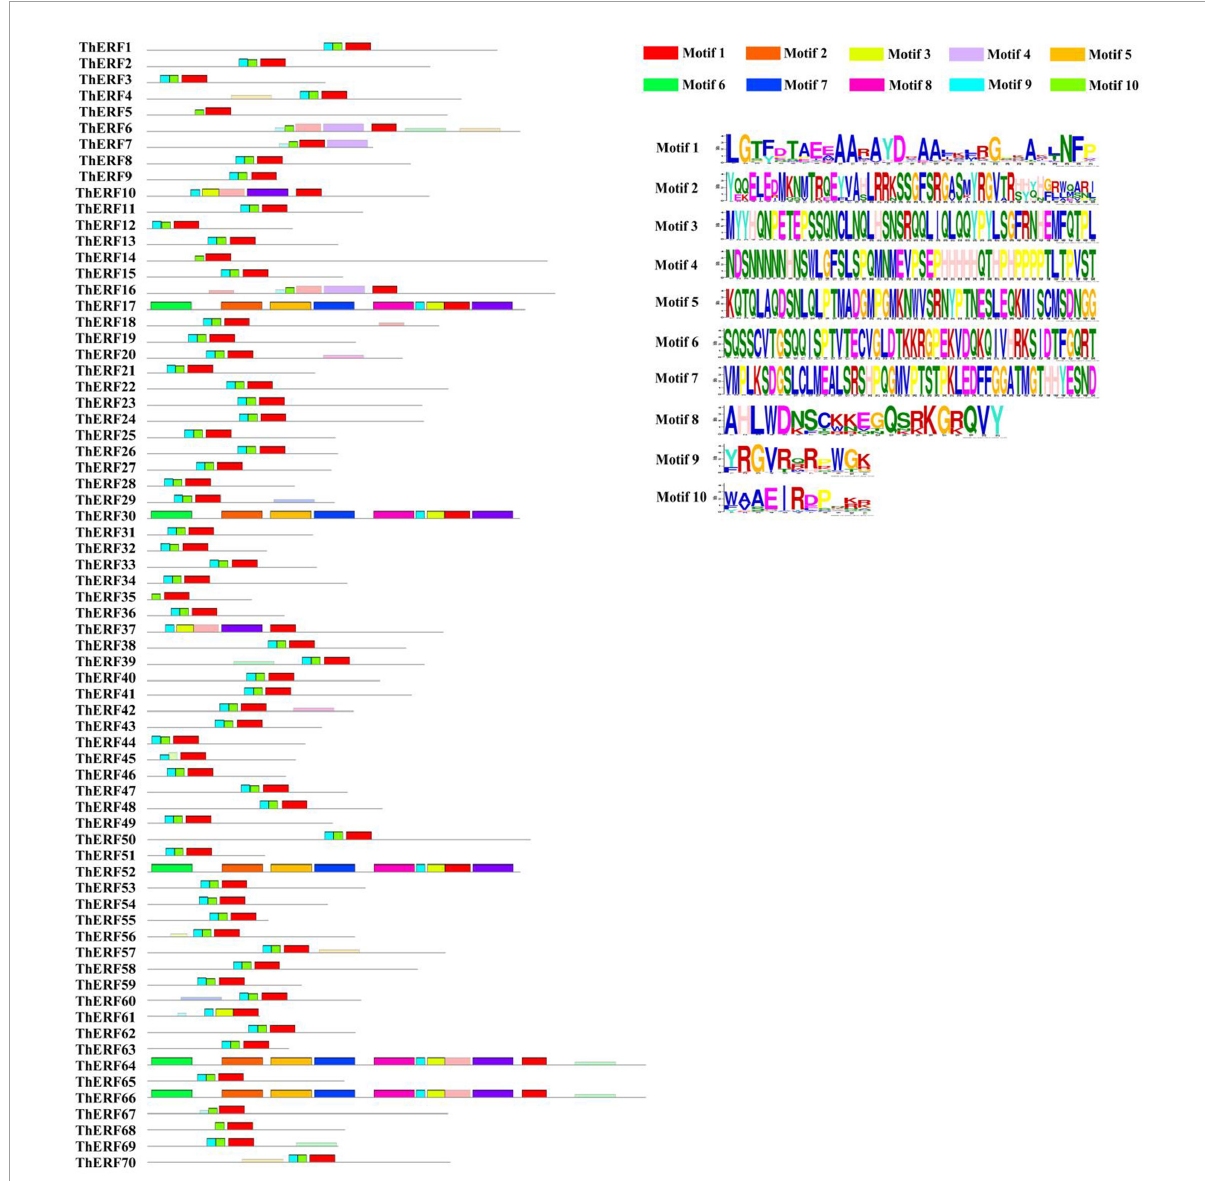
FIGURE1 Distribution of conserved motifs of the AP2/ERF transcription factors in T. hemsleyanum . Different motifs are highlighted in different colors.